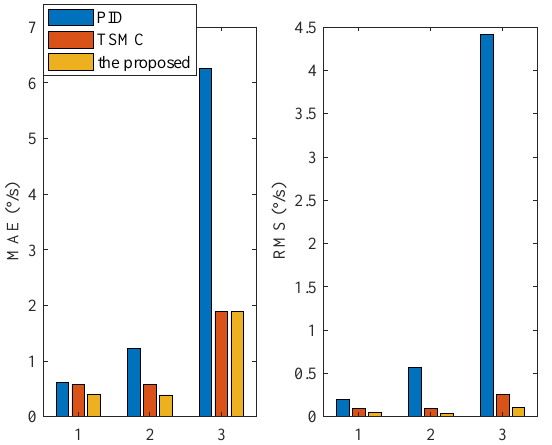
Figure 7. Simulation performance indexes under Case I with different tests.